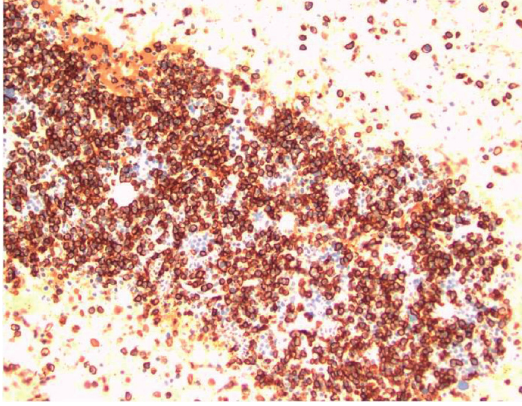
Figure 3: Bone marrow CD 138 IHC stain.